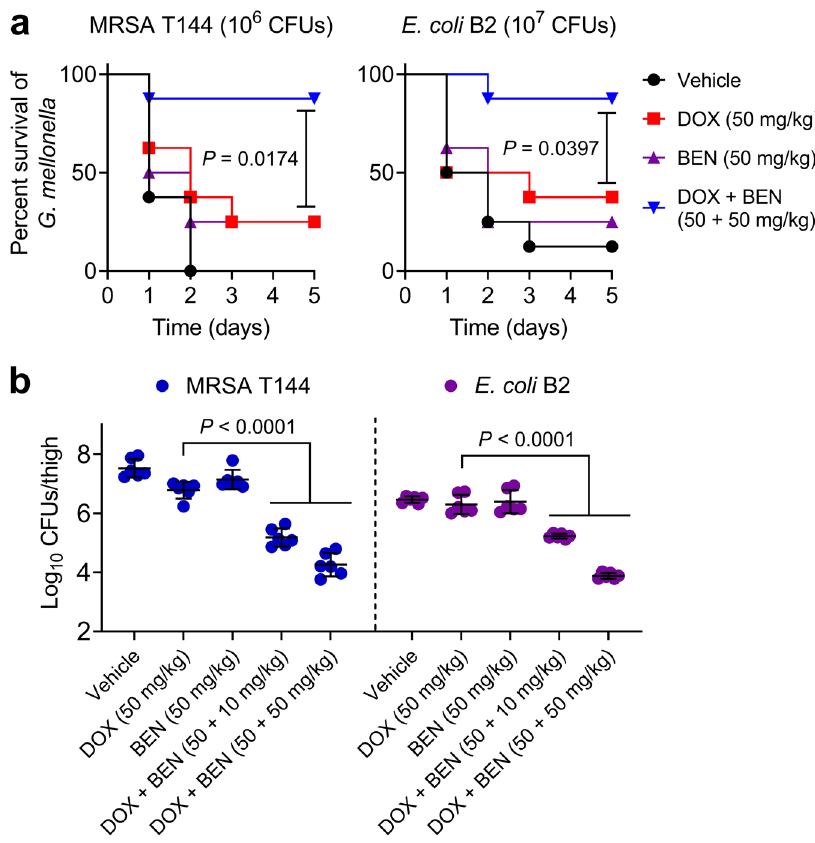
Fig. 7 Combination of doxycycline and bezydamine is ef fi cacious in various animal infection models. a Survival rates of Galleria mellonella ( n = 8 biologically independent animals per group) infected by MRSA T144 or E. coli B2 and then treated with doxycycline (50 mg/kg) or benzydamine (50 mg/ kg) alone or a combination of doxycycline plus benzydamine (50 + 50 mg/kg). P values were determined using the two-sided log-rank (Mantel – Cox) test. b Combination of doxycycline (50 mg/kg) and benzydamine (50 mg/kg) signi fi cantly reduces the thigh bacterial loads of mice ( n = 6 biologically independent animals per group) infected by MRSA T144 or E. coli B2 (10 5 CFUs per mouse) compared with doxycycline monotherapy (50 mg/kg). P values were calculated using a two-sided Mann – Whitney U